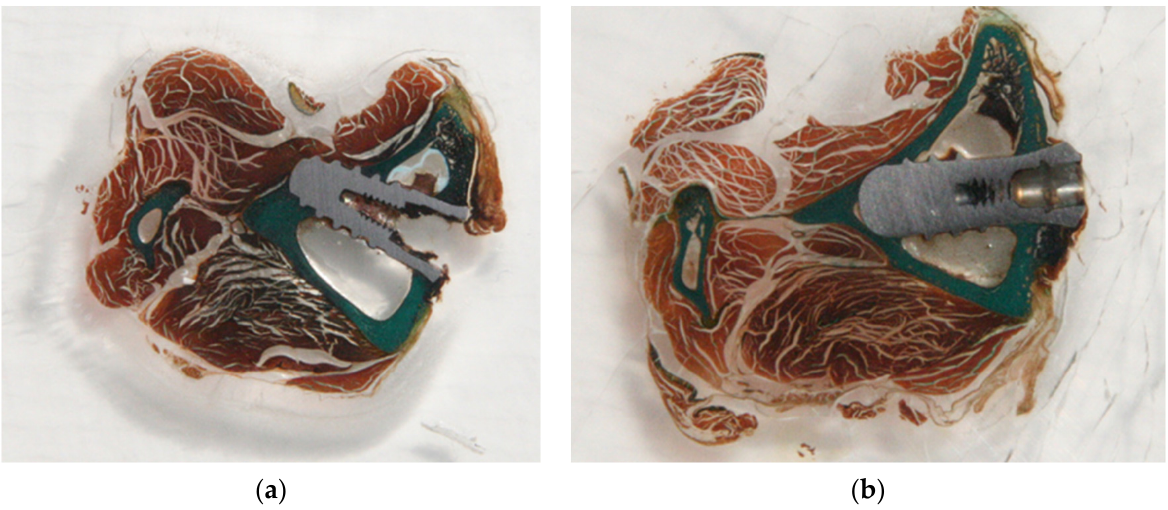
Figure 4. Histological cut of the implant section obtained by microscope: ( a ) SB implant; ( b ) SB+AE implant. Table 5. Results of ISQ values obtained by the Osstell Mentor II and Osstell ISQ systems at surgery and sacrifice time on both surfaces (SB and SB+AE).